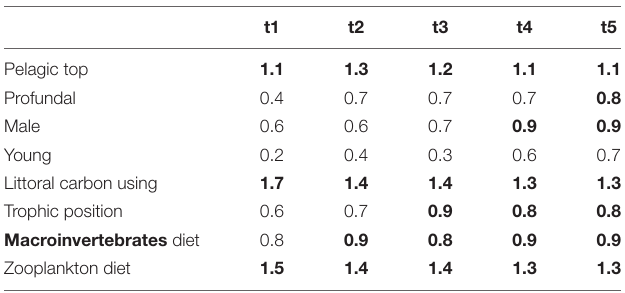
TABLE 6 | Results from PLS model 3 tested relationship between environmental and dispersal factors in